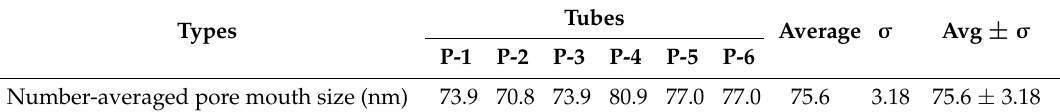
Figure 8. ( a ) Averaged pore mouth size distribution for PVDF membranes derived from six replicate samples; ( b ) liquid flux and pressure relationship of PVDF-1 membrane. Table 6. Summary of MLLDP results for six replicate samples of nominal 80 nm PVDF